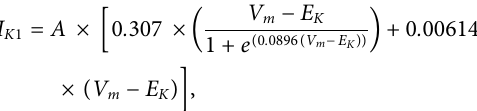
Frontiers in Pharmacology |